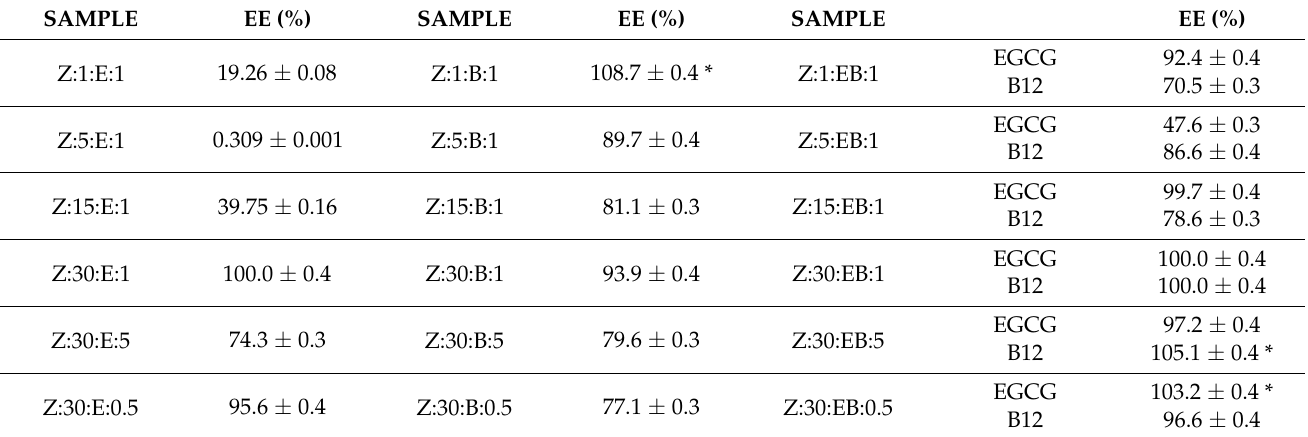
Table 3. Entrapment efficiency for the microstructures produced by